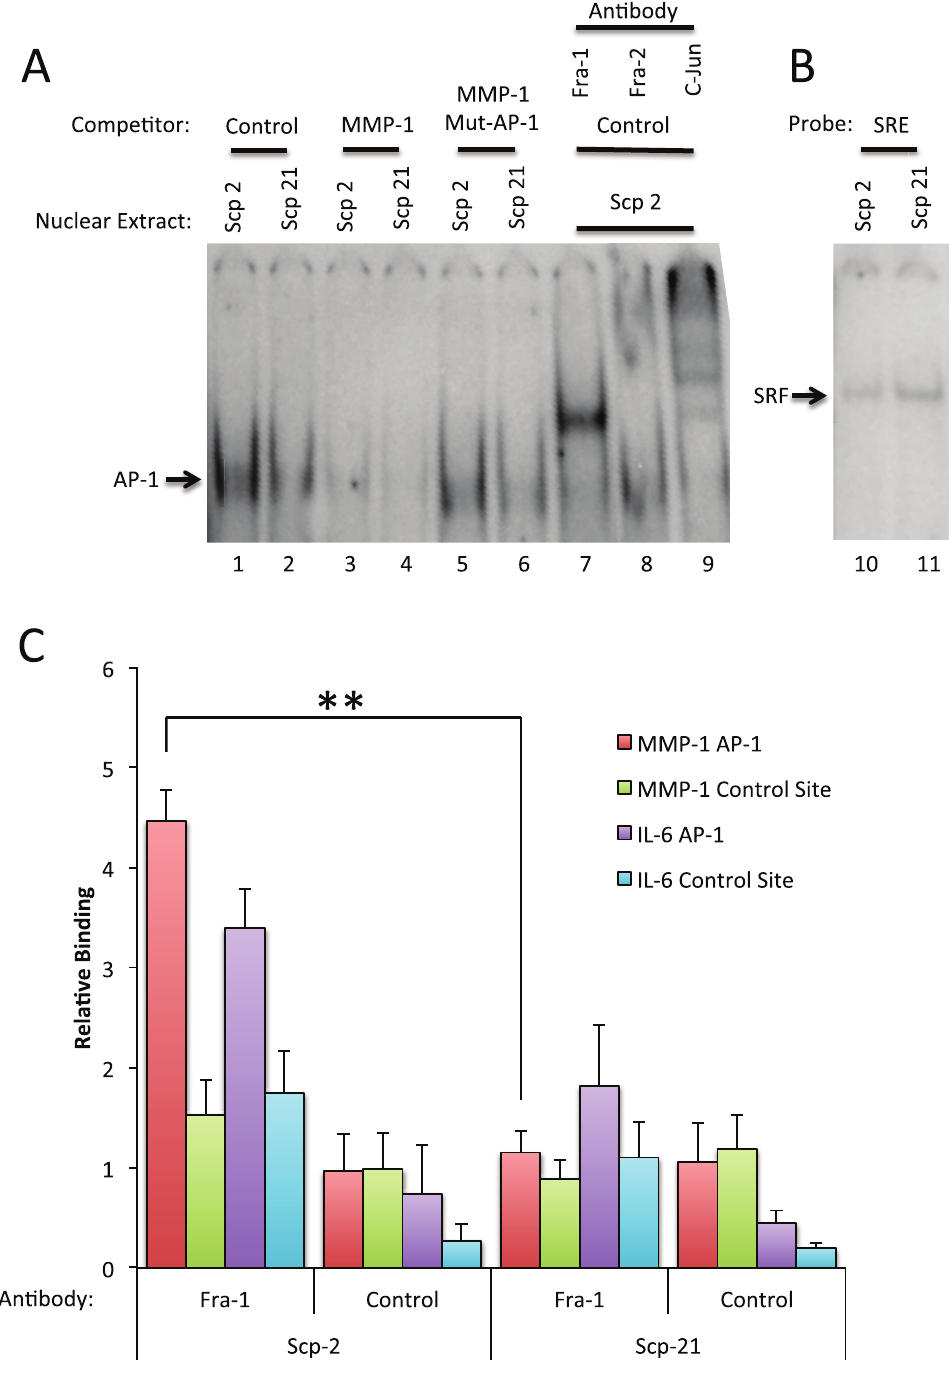
Figure 6. Fra-1 binds site of the MMP-1 promoter. A ) In vitro binding. Electrophoretic mobility shift assay (EMSA) with the MMP-1 AP-1 site. Scp-2 and Scp-21 nuclear extracts were incubated with a 32 P-end labeled MMP-1 promoter double-stranded oligonucleotide probe spanning the AP-1 consensus site (-107 to -57 bases relative to the transcription start site). Nonspecific competitor, unlabeled, and point mutant AP-1 site oligonucleotides were added in 250 fold excess of the probe. The final three lanes included anti-AP-1 family member antibodies. B ) Control EMSAs were preformed as in A except with a Serum Response Element probe to detect SRF binding. C ) In vivo binding. Chromatin immunoprecipitation with Scp-2 and Scp-21 cells immunoprecipated with anti-Fra-1 antibody or mock antibody control. The immunoprecipitated DNA from the samples was measured by qPCR for binding of Fra-1 to the MMP-1 AP-1 promoter site, an upstream non-AP-1 control MMP-1 site, the IL-6 gene AP-1 site, or an upstream non-AP-1 control IL-6 site. The data shown represent the mean fold over control DNA values +/- standard deviation for three indendent experiments. **, p < 0.005 for two-tailed